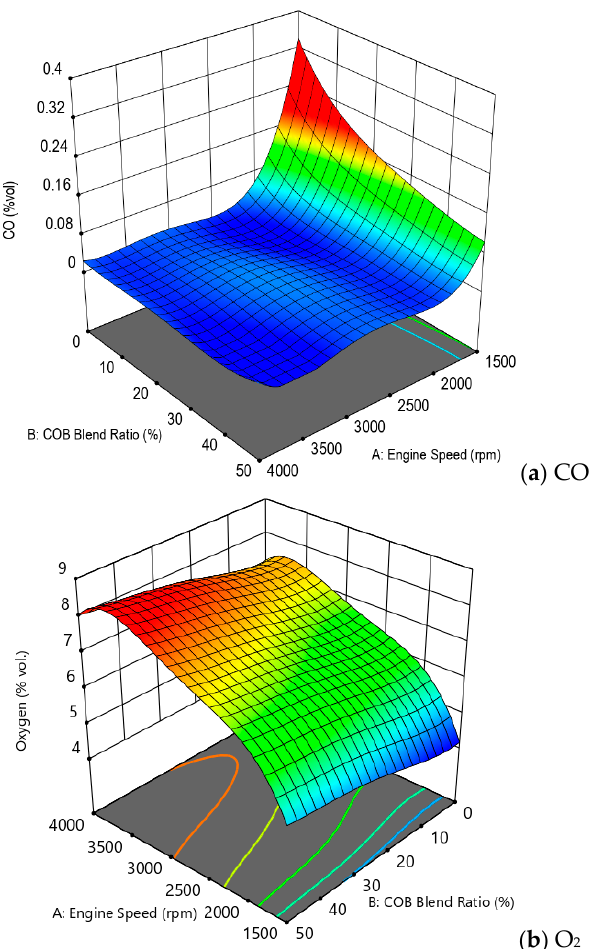
Figure 9. ( a ) CO and ( b ) exhaust oxygen concentration versus engine speed for all test fuels.